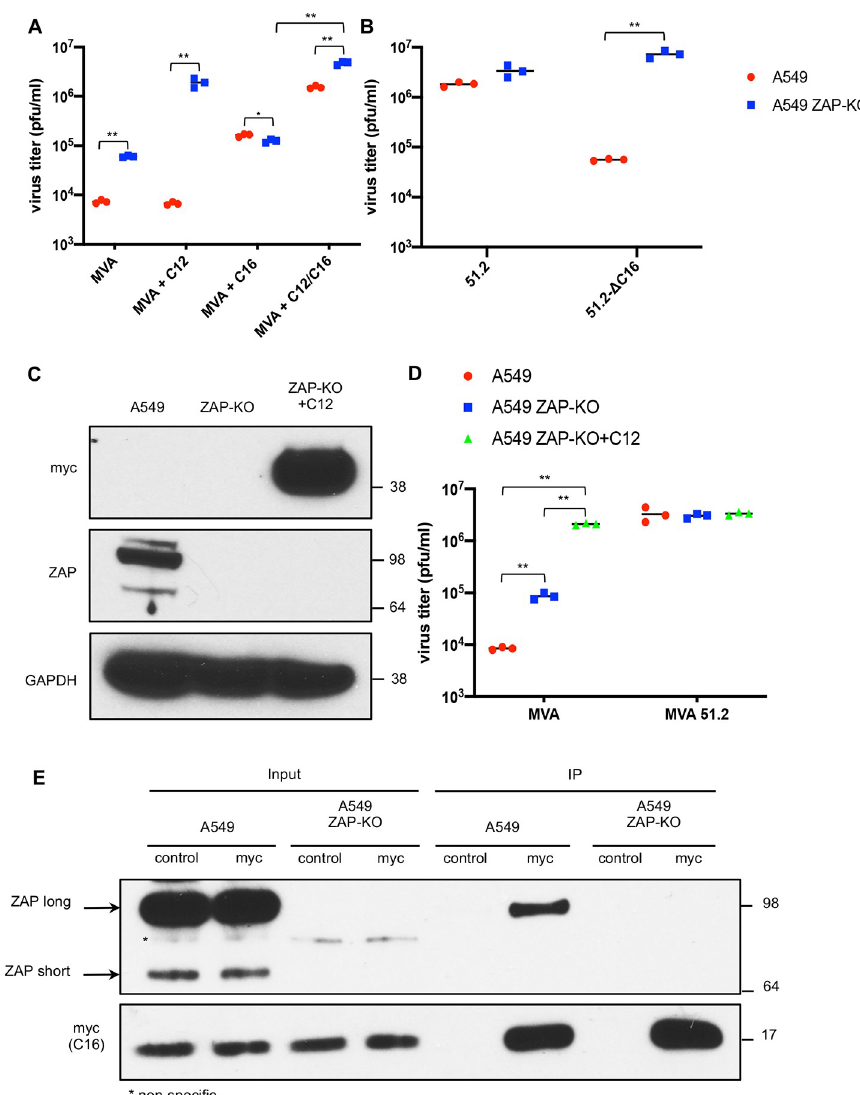
Fig 3. C16 antagonizes and interacts with ZAP. (A ) A549 cells were infected in triplicate with MVA, MVA+C12, MVA+C16 or MVA+C12/C16 at 0.01 PFU/cell. After 48 h, the cells were harvested and virus titers determined by plaque assay on CEF. Virus titers from each infection are shown as dots and the bar represents the mean value. ( B ) A549 and A549 ZAP-KO cells were infected with 0.01 PFU/cell of MVA 51.2 or MVA 51.2- Δ C16 and virus titers shown as above. ( C ) Lysates from A549, A549 ZAP-KO and A549 ZAP-KO cells stably expressing C12 (ZAP-KO +C12) were analyzed by SDS-PAGE and Western blotting with antibodies to myc tag on C12, ZAP and GAPDH, which was a loading control. Numbers on the right represent the electrophoretic positions and masses in kDa of marker proteins. ( D ) The cells described in C were infected with MVA or MVA 51.2 at 0.01 PFU/cell for 48 h and virus titers were determined by plaque assay on CEF. Virus titers from each infection are shown as dots and the bar represents the mean value. (E) A549 and A549 ZAP-KO cells were infected with MVA-2xMyc-C16 at 10 PFU/cell for 18 h. Cell lysates were incubated with control magnetic beads or myc-trap magnetic beads (myc), extensively washed and proteins eluted with lithium dodecyl sulfate (LDS) buffer and analyzed by SDS-PAGE and Western blotting with antibodies to ZAP and myc epitope tag. Statistics: � p < 0.05; �� p < 0.01 by two-sided Student’s